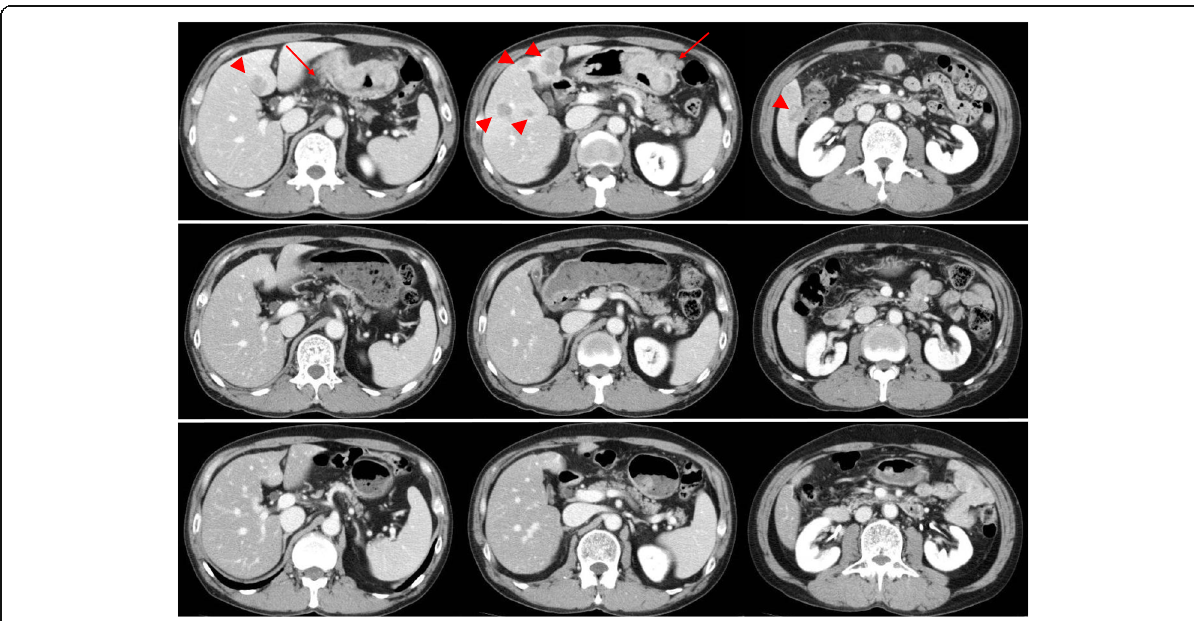
Fig. 2 Enhanced computed tomography scan findings. a Thickening of the anterior wall in the lower gastric body with enlargement of lymph nodes ( arrow ) along with the lesser curvature and greater curvature. Multiple liver metastases (arrowhead). b , c Complete response of liver metastases and lymph node metastases had been